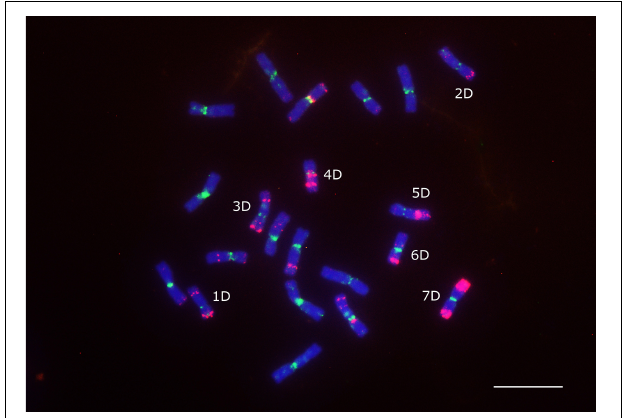
FIGURE 8 | Localization of CRM element (green signals) on the mitotic chromosomes of an F 1 hybrid from a cross between emmer wheat ( T. dicoccum “TazeabadAliabad”) and Ae. tauschii “G 299.” Oligo-pTa535-1 probe (red signals) was also applied to identify the D genome chromosomes. Scale bar = 10 µ